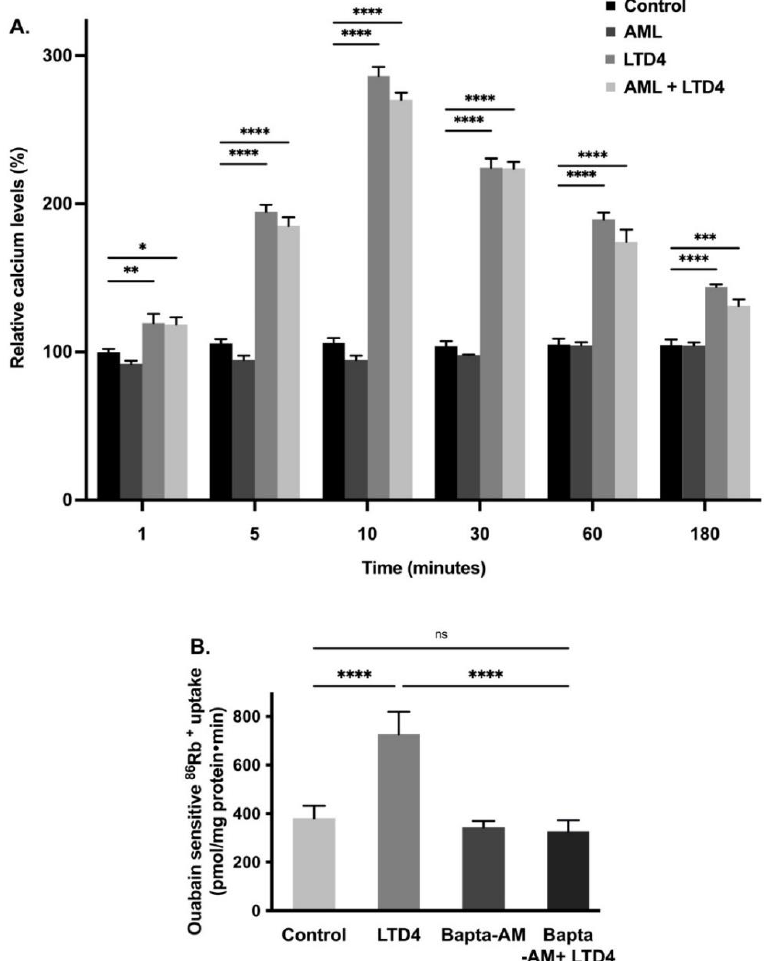
Figure 4. ( A ) Level of intracellular calcium at different time points during LTD4 treatment . Measurement of Ca 2+ by Fluo- 8 calcium flux assay. Values are relative to 1 min control ( n = 8. Tukey’s multiple comparisons test). Control and amlodi- pine (AML, calcium channel blocker, 1 nM ) alone did not change significantly at different time points. ( B ) Effect of calcium chelator BAPTA-AM (1 µM) on Na-K-ATPase activity in IEC-18 cells after 24 h. Measurement of Na-K-ATPase activity by 86 Rb + uptake ( n = 6, Tukey’s multiple comparisons test). Values are represented as means ± SEM. * p < 0.05, ** p < 0.01, *** p < 0.001 vs. control and **** p < 0.0001 vs. control. ns., not